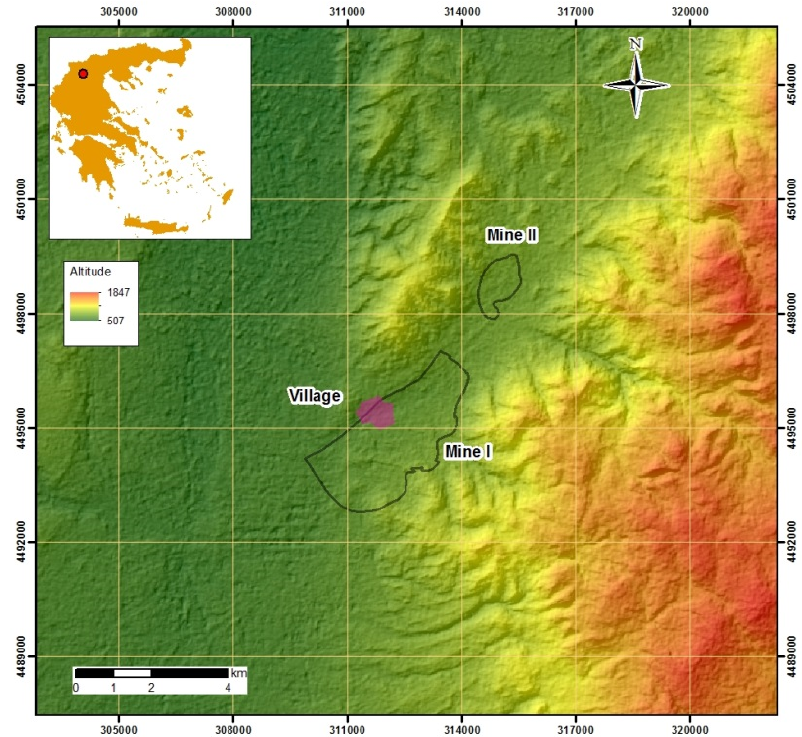
Figure 2. General overview of the mining area, including the boundaries of the two lignite fields (Mine I and Mine II).